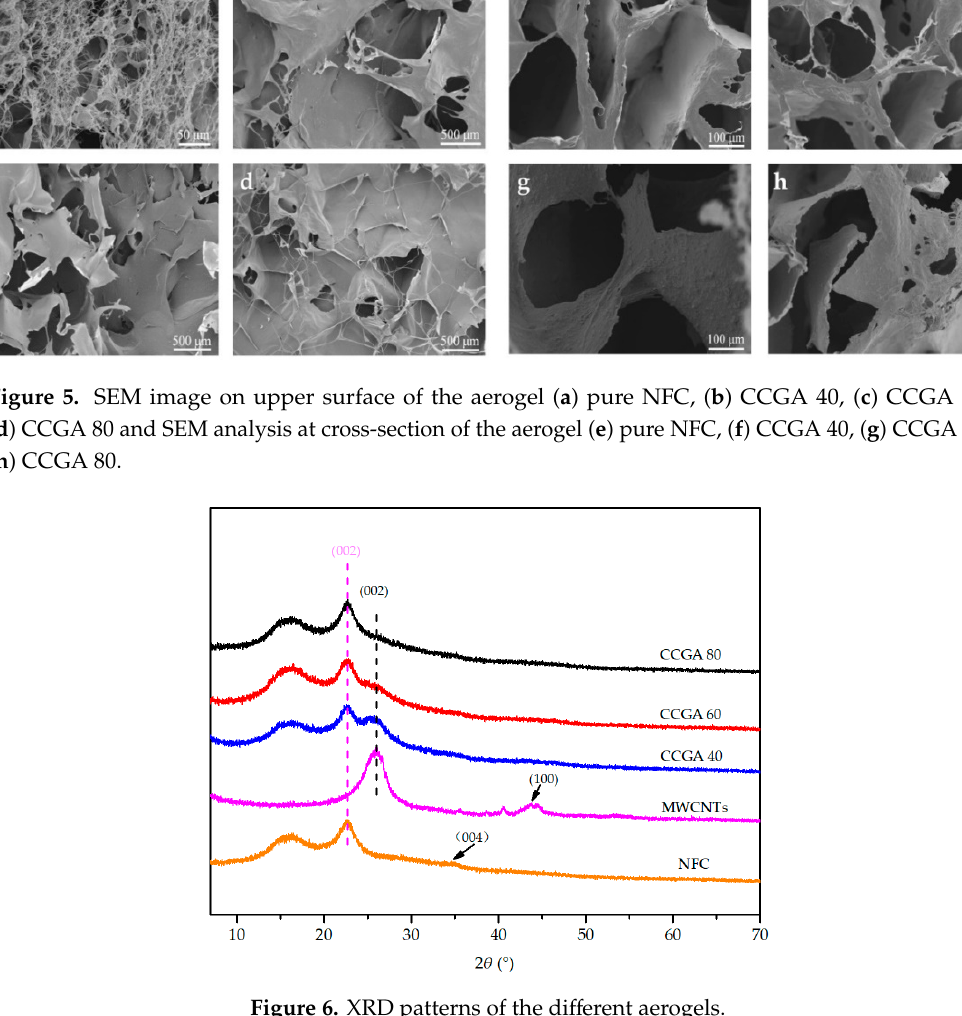
Figure 6. XRD patterns of the different aerogels.